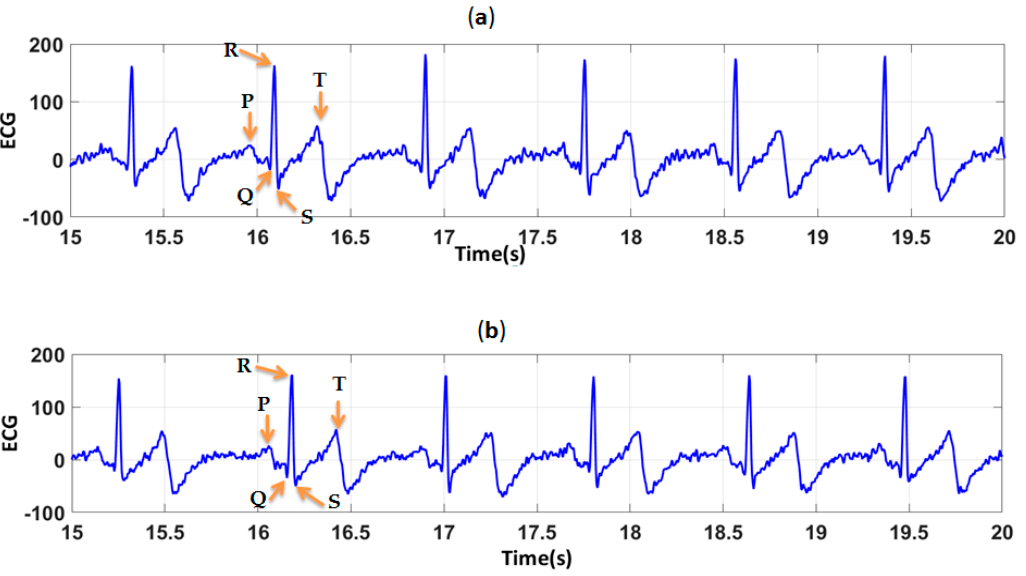
Figure 9. ECG signals, before washing, obtained by ( a ) polyamide textile electrodes coated by S1; ( b ) polyamide textile electrodes coated by S2.